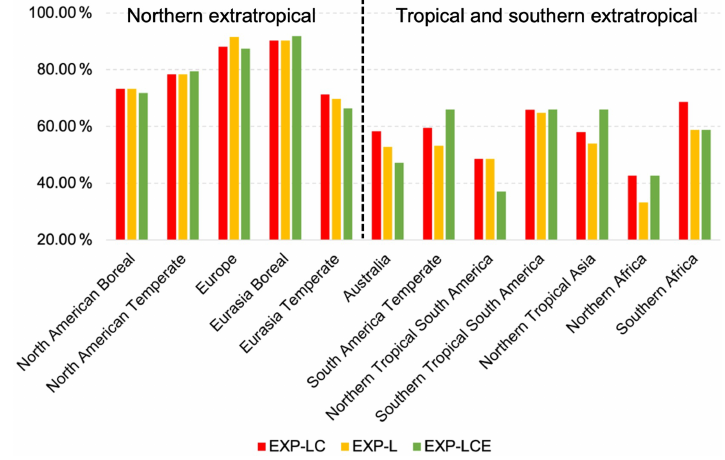
Figure A2. The RMSER in EXP-LC, EXP-L, and EXP-LCE.